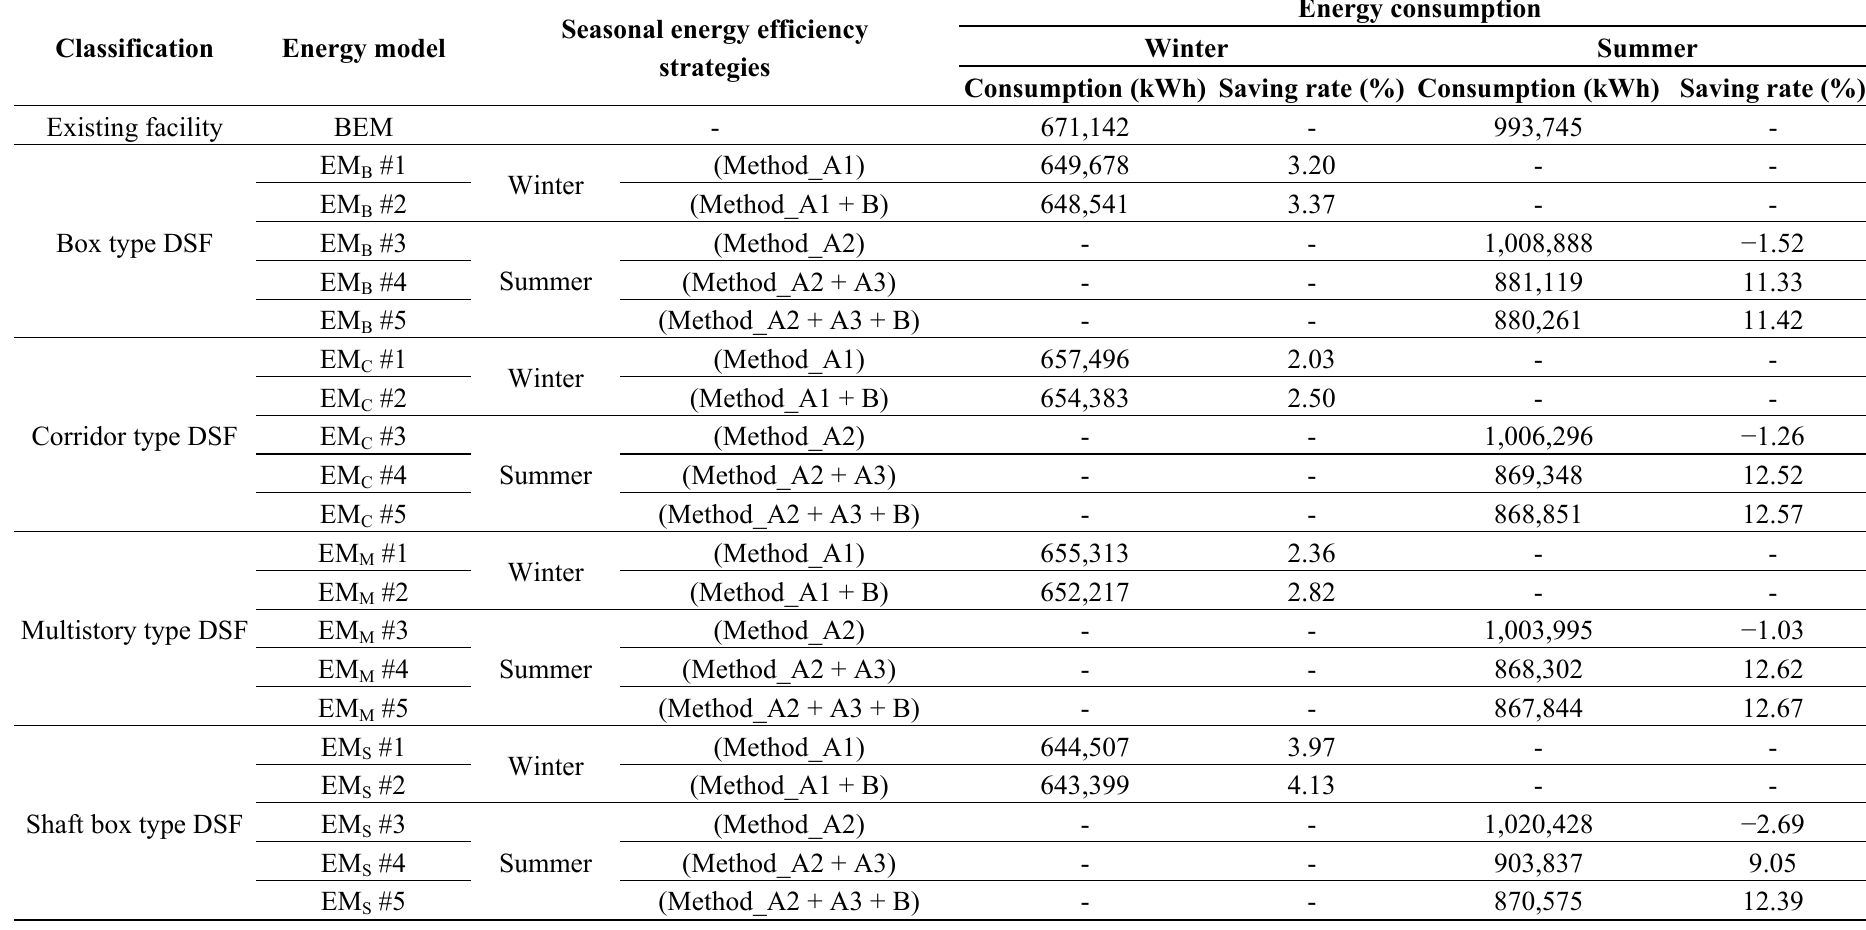
Table 6. Gas consumption by energy models with seasonal energy efficiency